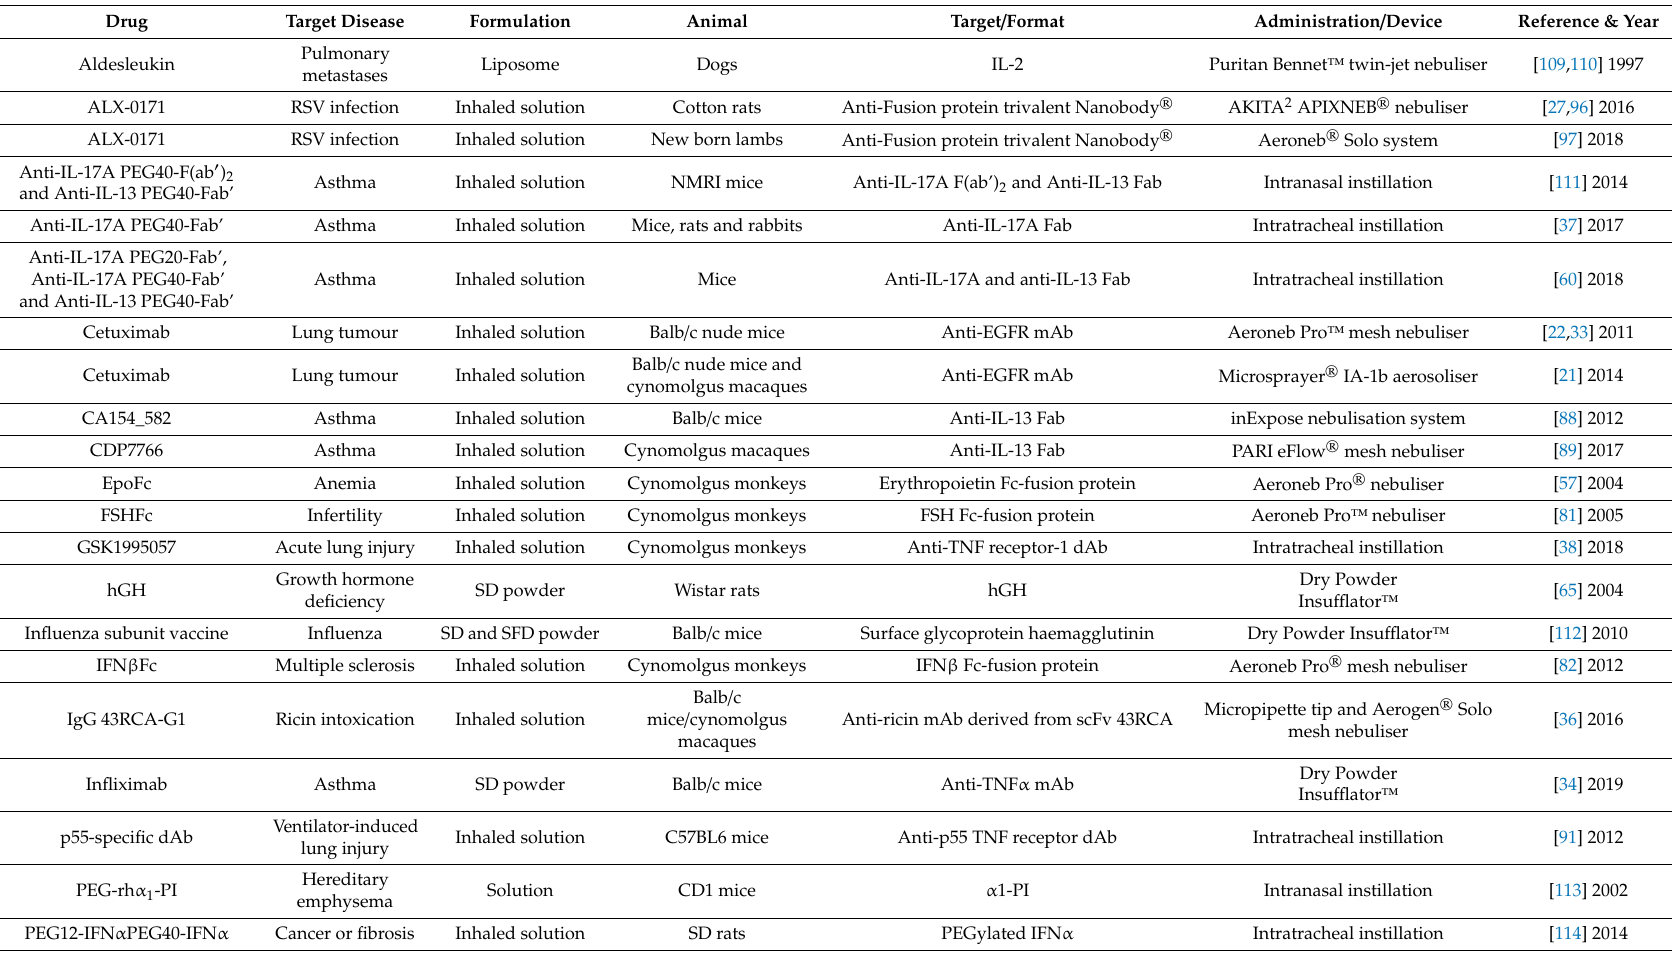
dAb: domain antibody; EGFR: epidermal growth factor receptor; FSH: follicle-stimulating hormone; hGH: human growth hormone, IFN β : interferon beta; IL: interleukin; PEG: polyethylene glycol; RSV: respiratory syncytial virus; rh α 1 -PI: recombinant α 1 -proteinase inhibitor, scFv: single-chain variable fragment; SD: spray dried; SFD: spray freeze dried; TNF: tumour necrosis